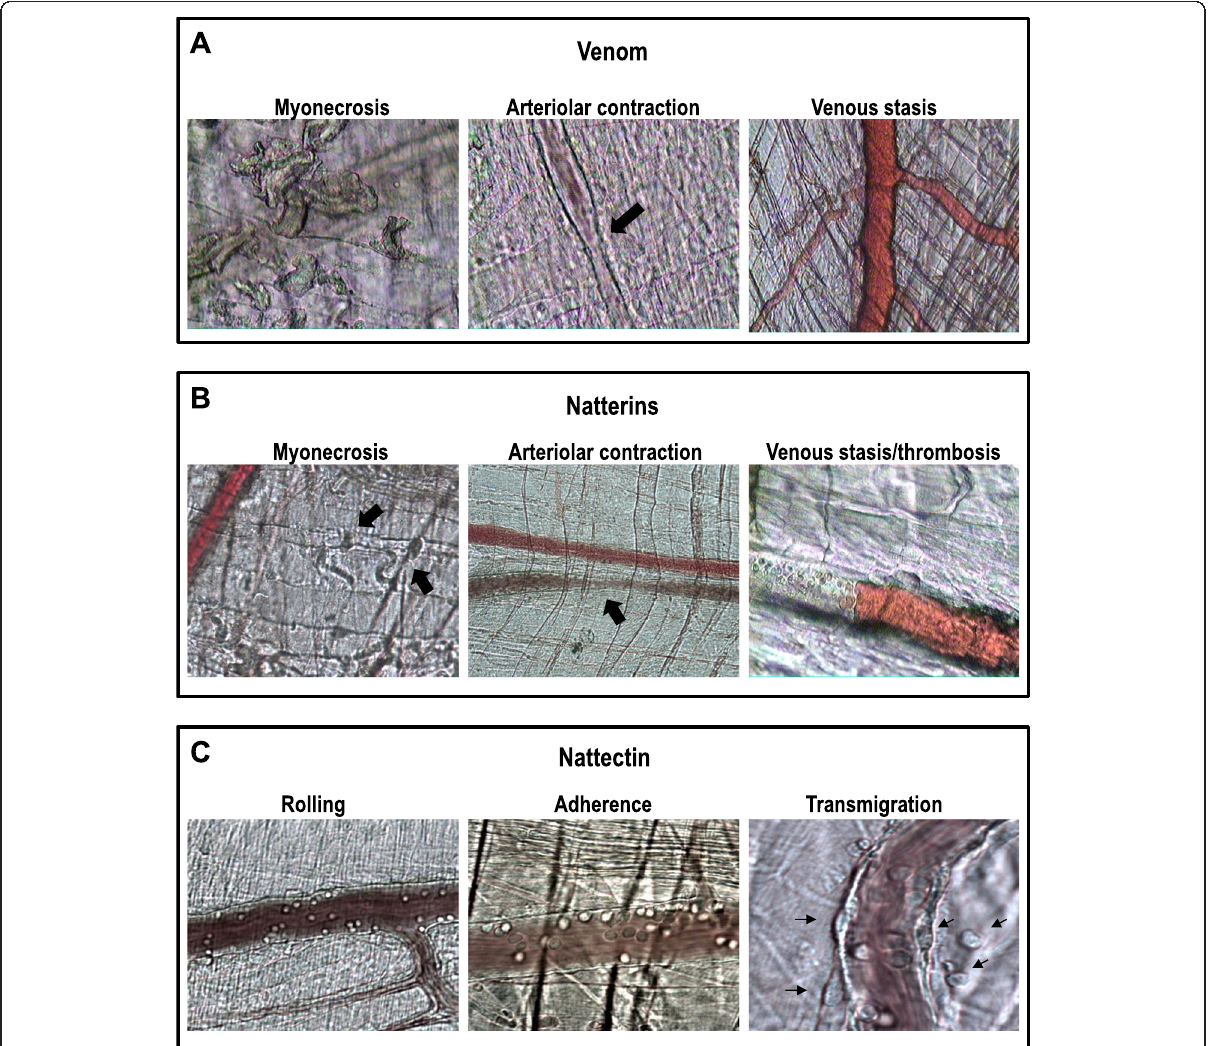
Figure 3 Microcirculation of the cremaster muscle. Intravital microscopy analyses of the microvascular network of cremaster muscle submitted to intraescrotal injection of (A) venom, (B) natterins and (C) nattectin. Venom and toxins elicits a peculiar alteration of the microcirculation that includes effects on platelets, endothelial cells and